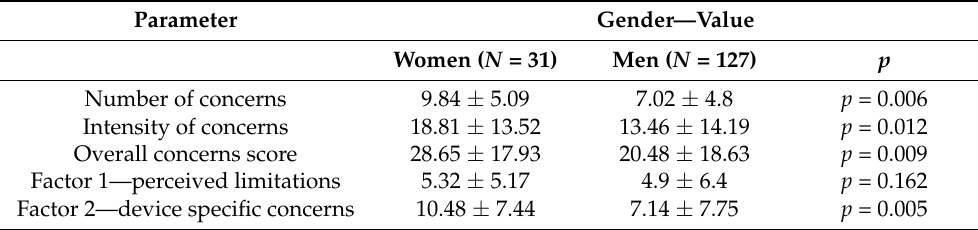
Table 4. Gender and concerns after ICDC implantation.